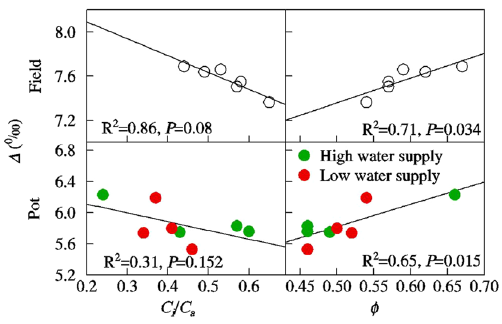
Figure 4. Relationships among stable carbon isotope discrimination ( Δ ), bundle sheath leakiness ( Ф ), and the ratio of internal and ambient CO 2 concentrations ( C i / C a ). Each data point shows the mean of samples taken from the pot experiment (N = 4) or the field experiment (N =